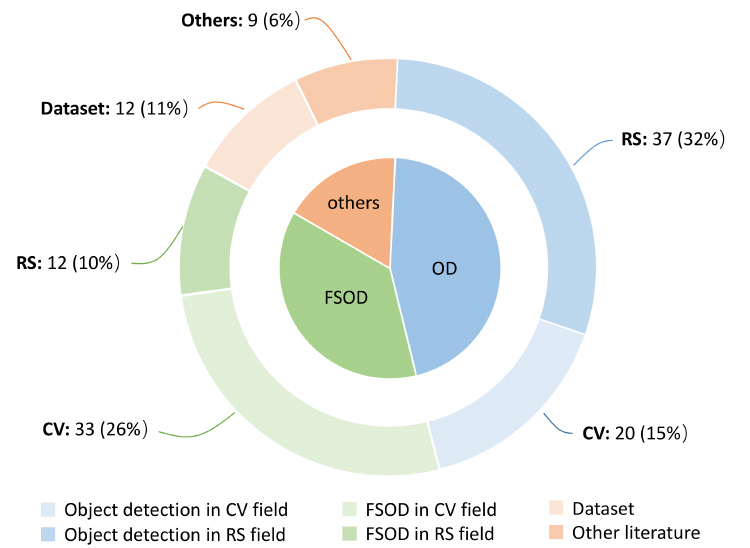
Figure 1. Literature cited in this paper. OD refers to object detection. Not all FSOD works in CV field are included because of their value in remote sensing image interpretation.